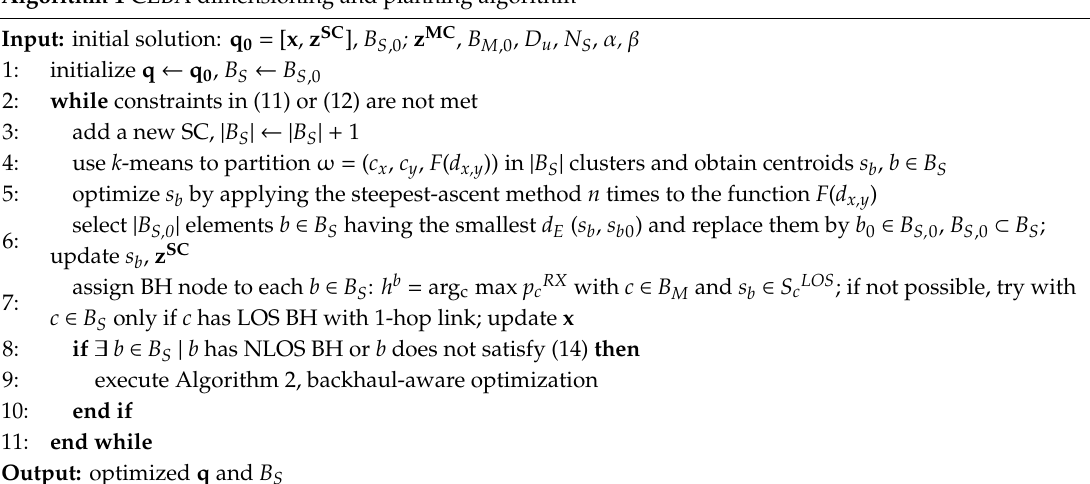
Algorithm 1 CEBA dimensioning and planning